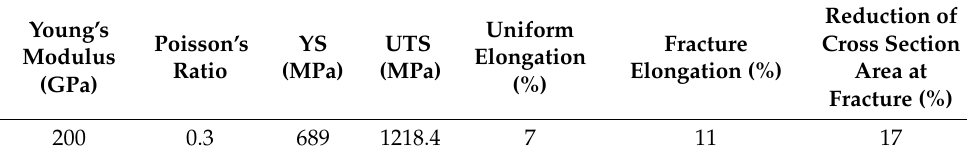
Table 2. Mechanical properties of SUJ2Z.